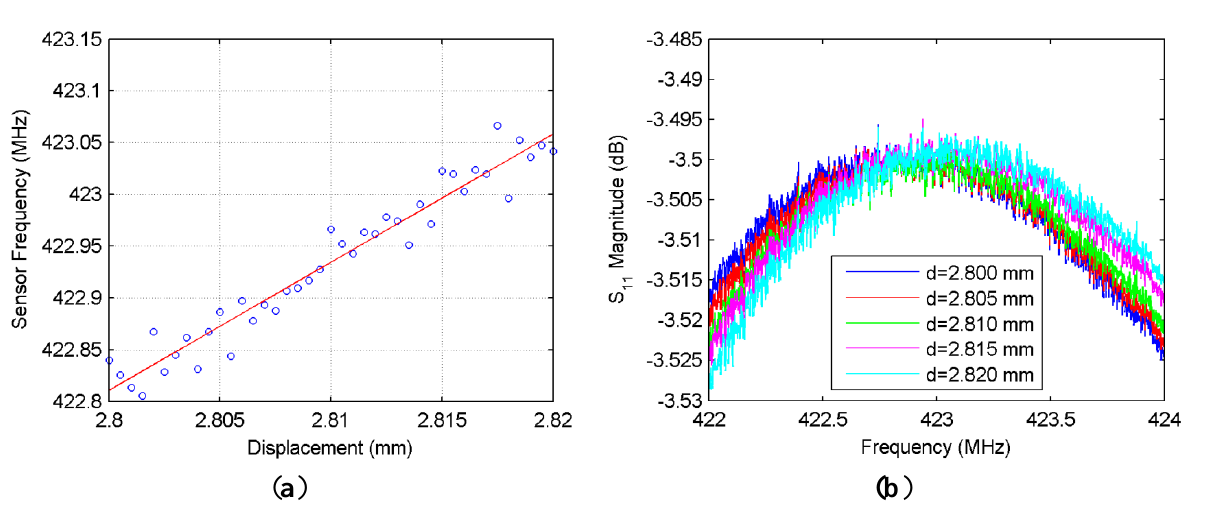
data that shows the shifting of the 11